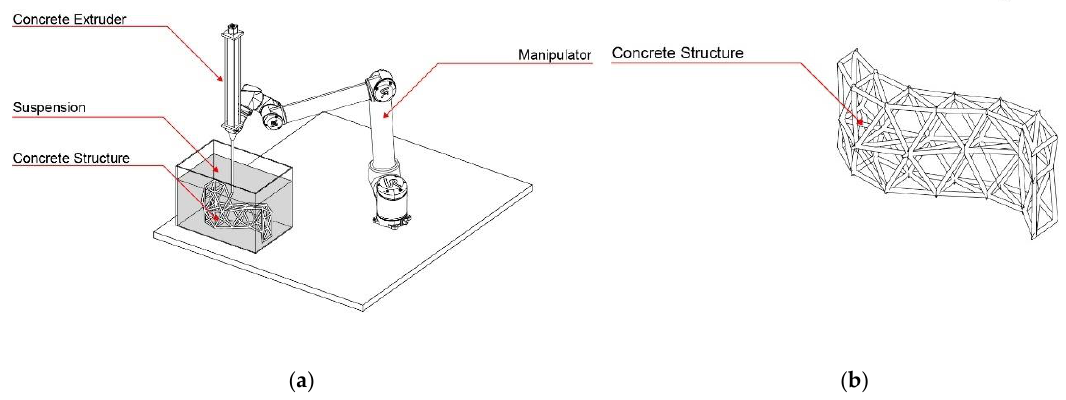
Figure 1. Concrete in Suspension (CiS): ( a ) fabrication process diagram; ( b ) printed lattice structure.